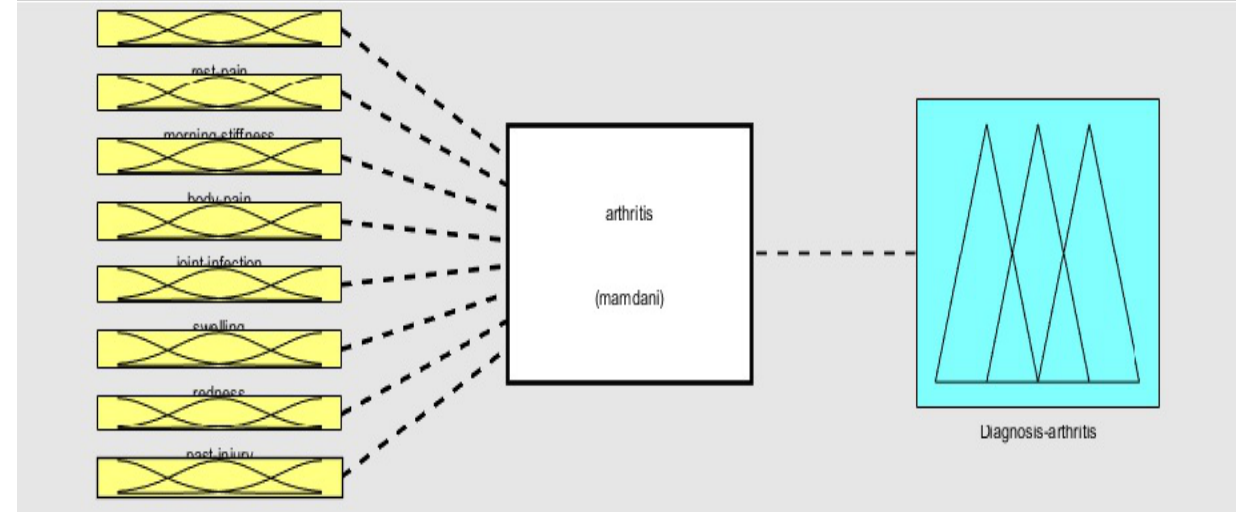
Figure 3. Layer-1 of Proposed DA-AH-MFES Expert System using MATLAB R2019a tool